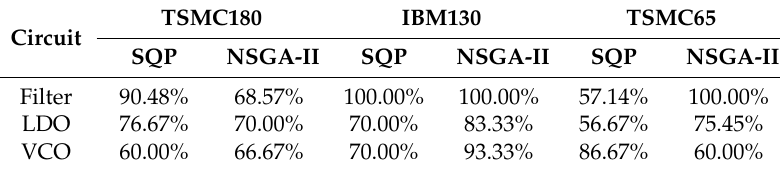
Table 8. Summary of success rate from surrogate evaluation to simulation verification across